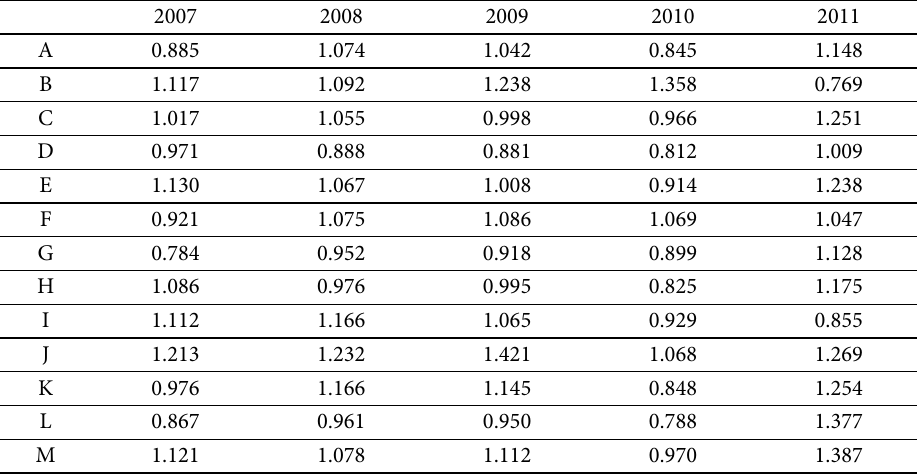
Table 4. Sector betas in 2007–2011 period